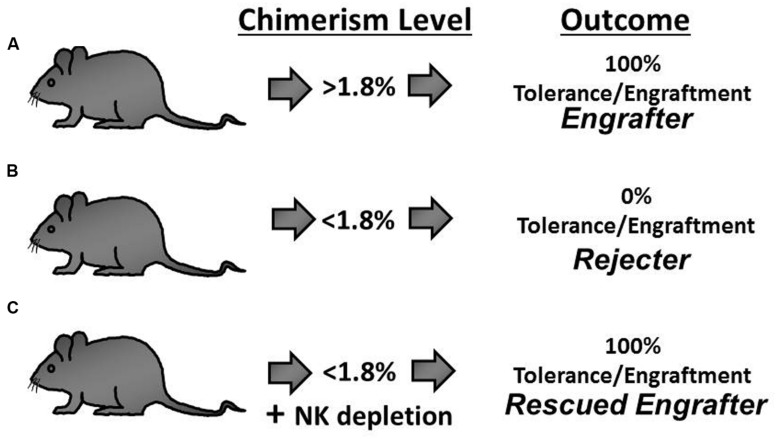
The outcome of engraftment or rejection following allogeneic In utero hematopoietic cellular transplantation (IUHCT) is predicted by the early chimerism level and hinges on the development of NK cell tolerance. (A) Mice with an early chimerism level above the chimerism threshold (Engrafter mice; >1.8% circulating chimerism) exhibit durable long-term multi-lineage engraftment. (B) With early chimerism levels below the chimerism threshold, NK cell tolerance does not develop and universal rejection occurs (Rejecter mice; <1.8% circulating chimerism). (C) Rejection is abrogated when NK cells are depleted in rejecter mice thereby rescuing prenatal engraftment (Rescued Engrafter mice).